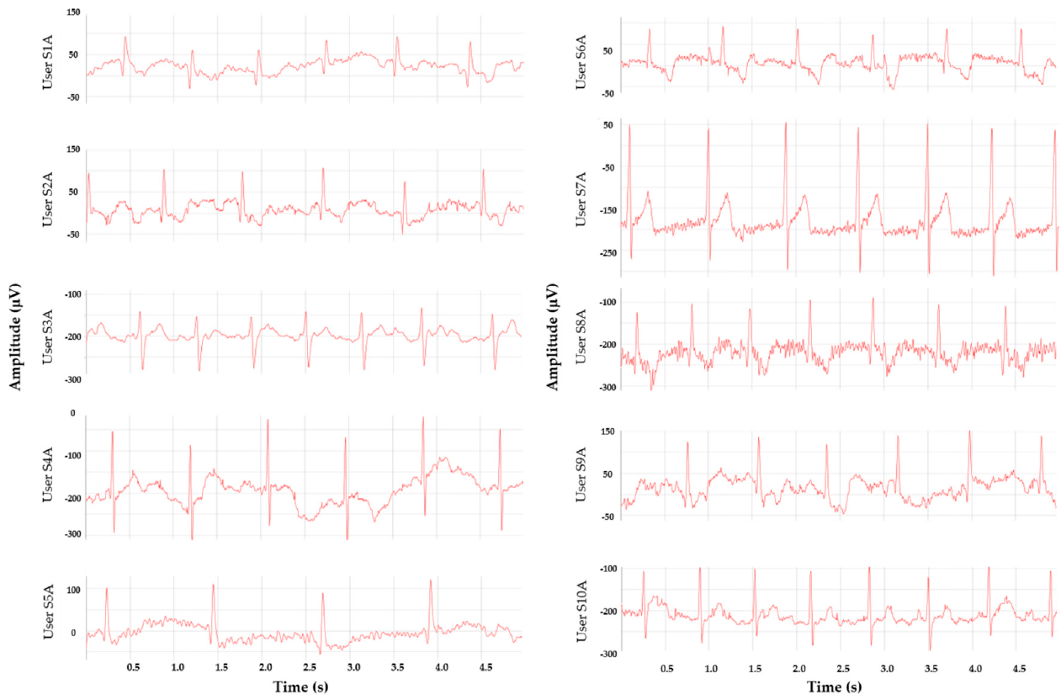
Figure 22. Raw arm-ECG signals recorded from users resting.